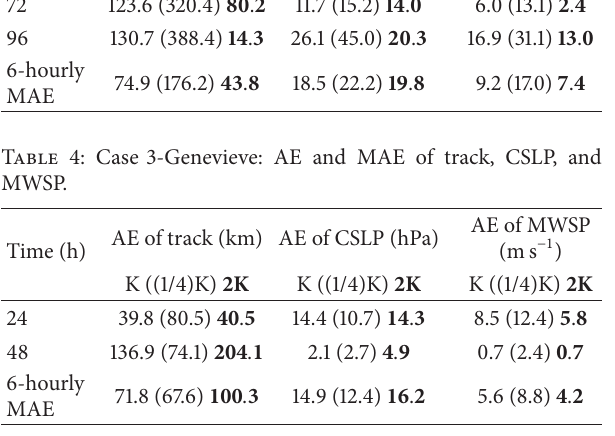
Table 8: Case 7-Hagupit: AE and MAE of track, CSLP, and MWSP. Time